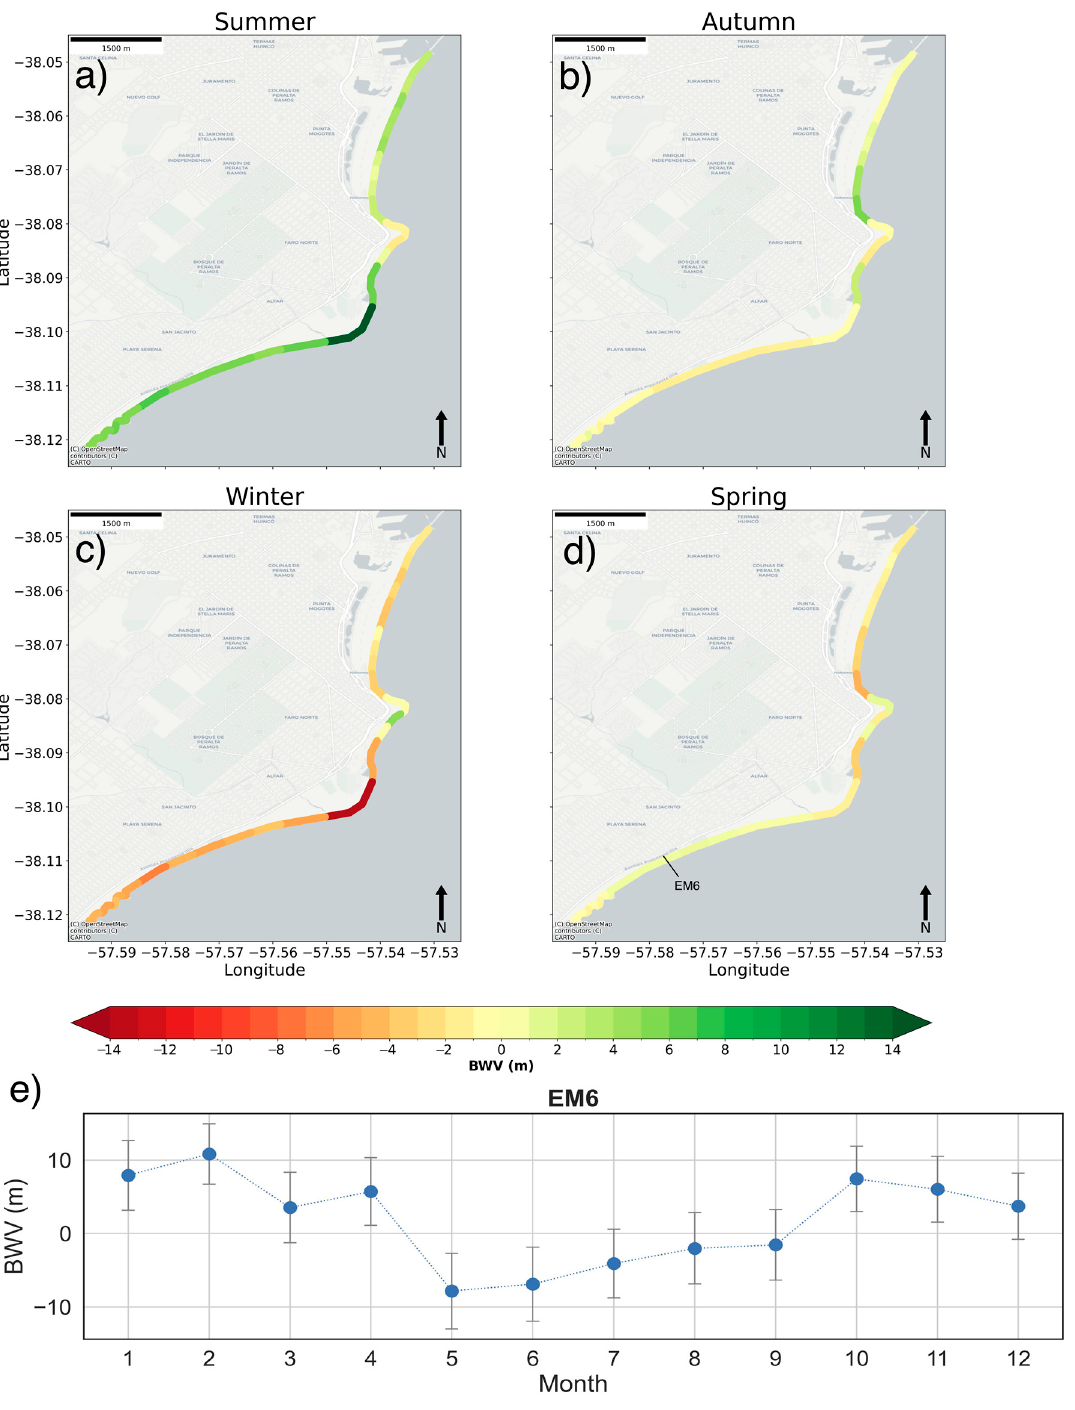
Figure 5. BWV seasonal average for period 1986–2020 in ( a ) summer, ( b ) autumn, ( c ) winter, and ( d ) spring in the study area. Erosion places are indicated by reddish colors and accretion ones by greenish colors. ( e ) BWV monthly average and standard deviation of EM6 transect for the entire period.